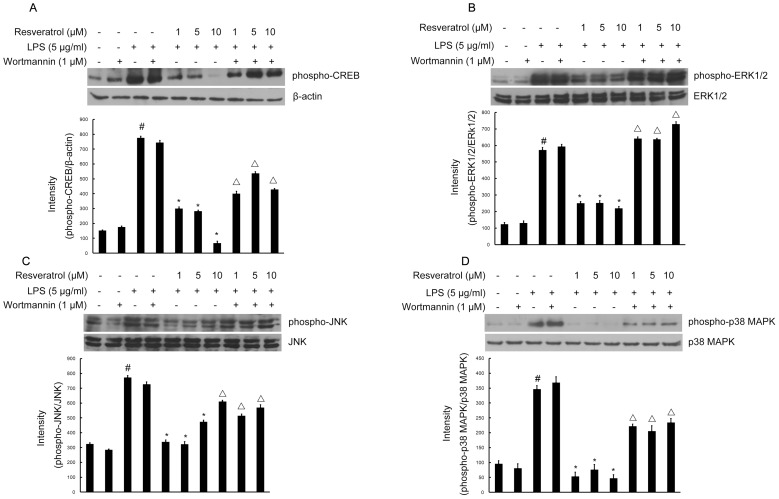
Inhibition of the phosphorylation of CREB, and MAPKs signaling by resveratrol is PI3-K-dependent during RAW 264.7 macrophage cells activation by LPS.Approximately 1×106 cells/ml were seeded in six-well plates and incubated until 80% confluency. Cells were pre-treated with resveratrol (1, 5, and 10 µM) for 1 h in the absence or presence of wortmannin (1 µM), then exposed to LPS (5 µg/ml) for 30 min. Cell lysates (50 µg protein) were prepared and subjected to Western blot analysis by using antibodies specific for phosphorylated forms of CREB, ERK1/2, JNK and p38 MAPK (shown as phospho-IκB-α, etc.) as described in the methods. Equivalent loading of cell lysates was determined by reprobing the blots with anti-β-actin, total ERK1/2, JNK or p38 MAPK antibodies. The relative protein levels were quantified by scanning densitometry and normalized to β-actin, total ERK1/2, JNK or p38 MAPK. The values shown are mean ± SEM of data from three independent experiments. #Significant compared with control alone, p<0.05. *Significant compared with LPS alone, p<0.05. ΔSignificant compared with resveratrol + LPS, p<0.05.